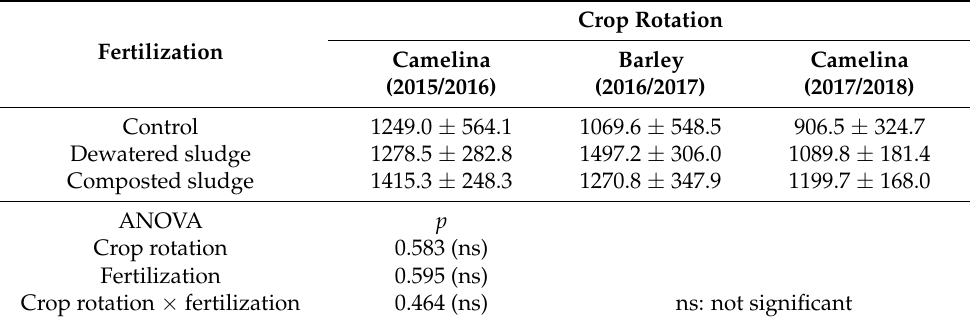
Table 2. Crop yield (kg ha − 1 ) obtained for the crop rotation camelin–barley–camelina considering the three fertilization treatments (dewatered sludge fertilization, composted sludge fertilization, and the control without fertilization).